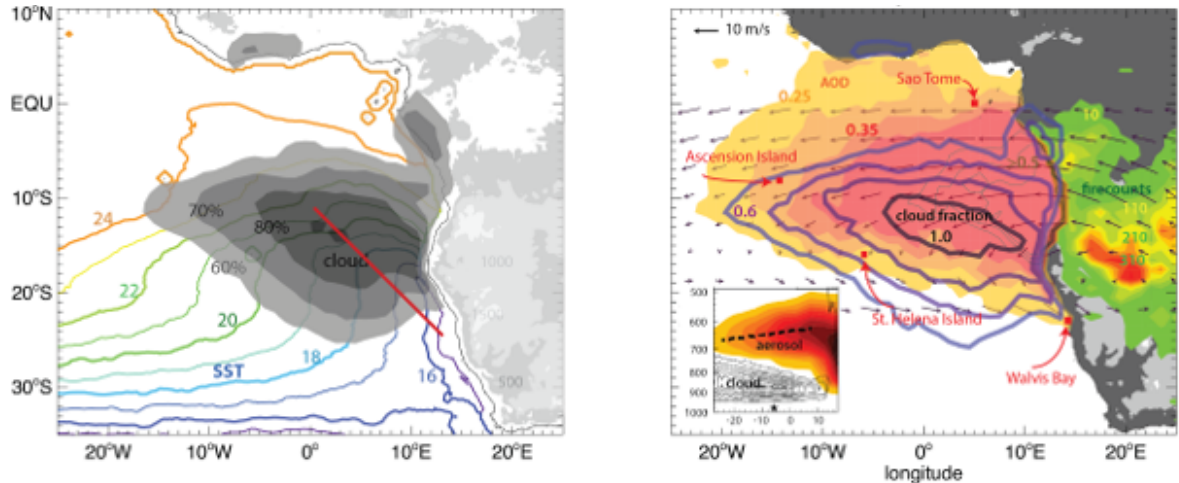
Figure 1. Left: September 2003–2016 WindSat sea surface temperature climatology (colored contours) and 2000–2016 Terra MODIS low cloud fraction climatology (gray shaded contours), with the routine flight track superimposed (red line). Right: September mean climatology of MODIS low-level cloud fraction (2002–2012; blue to black contours, 0.6–1.0 increments of 0.1), fine-mode aerosol optical depth (yellow– red shading indicates 0.25–0.45 in increments of 0.05 and very light black contour lines indicate 0.5–0.7 in increments of 0.1), and fire pixel counts (green–red shading, 50–310 fire counts per 1 ◦ box in increments of 50), and ERA-Interim 2002–2012 600hPa winds (referenced at 10ms − 1 ). Inset: September mean 6–17 ◦ S latitude cross section of Cloud-Aerosol Lidar with Orthogonal Polarization (CALIOP) smoke aerosol count (2006–2012) and CloudSat cloud fraction (2006–2010). The CloudSat cloud fraction is calculated following Stein et al. (2011). The right panel figure was reproduced from Zuidema et al. (2016). © American Meteorological Society. Used with permission. Table 1. Specifications of the observations used in this